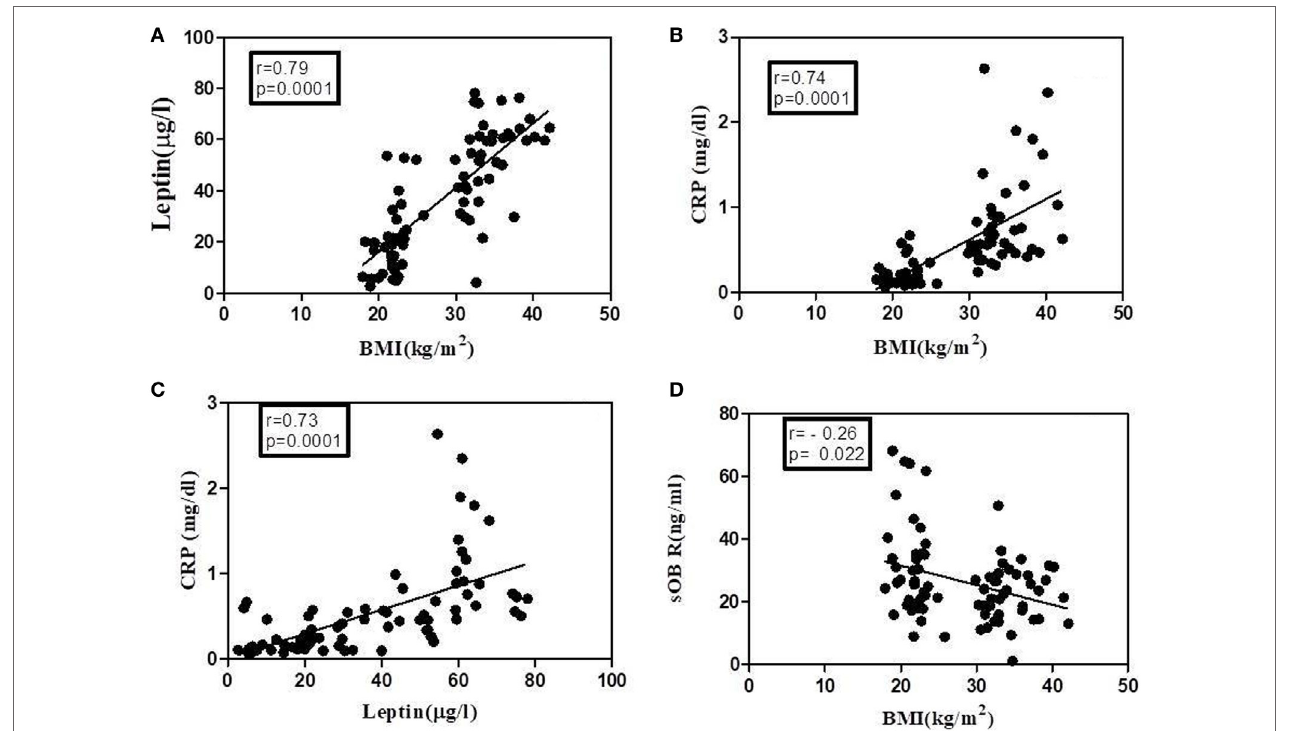
FigUre 7 | Correlation of leptin, C-reactive protein (CRP), and soluble leptin receptor (sOb R) with body mass index (BMI) analyses of correlation of BMI with serum levels of leptin, CRP, and sOb R as well as that between leptin and CRP was done using Spearman coefficient of correlation. A value of p < 0.05 was considered significant. Dark circles represent individual values. (a) BMI and leptin ( n = 78, r = 0.79), (B) BMI and CRP ( n = 78, r = 0.74), (c) leptin and CRP ( n = 77, r = 0.73), and (D) BMI and sOb R ( n = 79, r = −